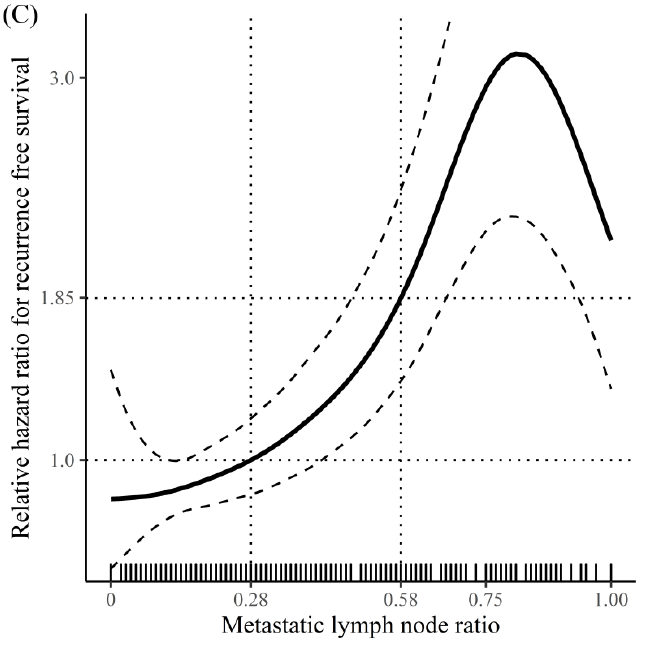
Figure 2. Restricted cubic spline graph showing nonlinear associations between lymph node (LN) -related continuous variables and hazard ratio for recurrence-free survival and the new cutoff values of LN-related risk factors generated using the K-means clustering algorithm: ( A ) maximal diameter of metastatic LN foci, ( B ) the number of metastatic LN, and ( C ) metastatic LN ratio. When the LN-related continuous variables were converted into categorical variables using these optimal cutoff values, the following were found to be independent risk factors for structural recurrence: maximal diameter of MLN foci >1.1 cm (HR, 2.16 [CI, 1.21 – 3.87];